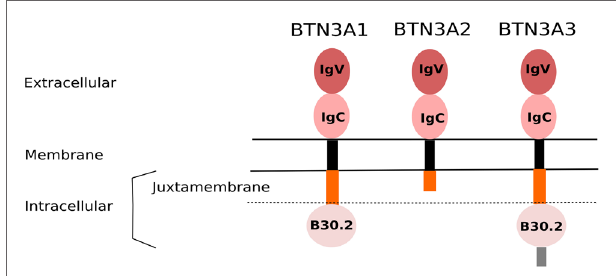
FiGURe 1 | Domain organization of BTN3A isoforms. The BTN3A family proteins share a high structural homology, mainly through their extracellular domain comprising a membrane-proximal IgC and a N-terminal IgV domains. They are linked to a poorly conserved intracellular part via a single transmembrane structure (black). The submembrane region (orange) represents the juxtamembrane domain (JTM). BTN3A1 and BTN3A3, but not BTN3A2, contain an intracellular B30.2 domain. The BTN3A3 isoform is further composed of an additional C-terminal extension